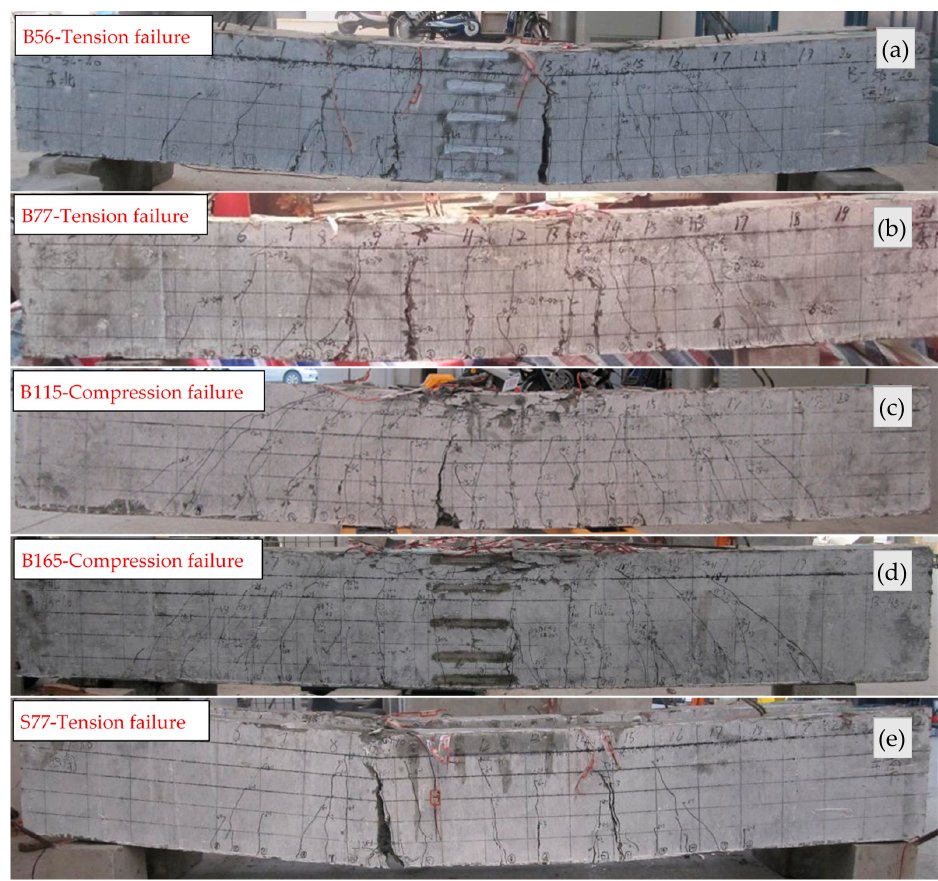
Figure 9. Failure modes: ( a ) B56; ( b ) B77; ( c ) B115; ( d ) B165; ( e ) S77.